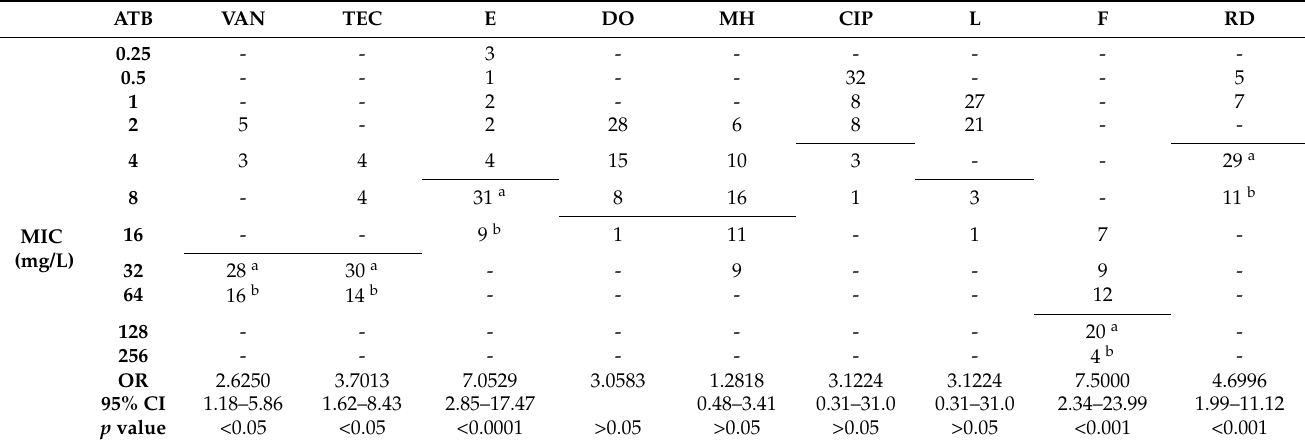
For the antibiotic vancomycin at a concentration of 32.0 mg/L, out of a total of 52 isolates of Enterococcus sp., 28 isolates (53.85%) were resistant, while at a concentration of 64.0 mg/L, 16 isolates (30.77%) were resistant. The antibiotic teicoplanin at a concen- tration of 32.0 mg/L showed a number of resistant isolates (30; 57.67%). At twice the concentration of the antibiotic teicoplanin 64.0 mg/L, 14 isolates were resistant (26.92%), a decrease of 53.33% compared to the dose of 32.0 mg/L. The p value of vancomycin and teicoplanin is significantly lower than the alpha, and this difference is statistically significant ( p < 0.05). Resistance to the antibiotic erythromycin (E) was determined from concentrations of 8.0 mg/L and 16.0 mg/L. At a concentration of 8.0 mg/L, 31 isolates were resistant (59.62%). However, at a concentration of 16.0 mg/L, only 9 isolates (17.31%) were resistant. The odds ratio (OR) is 7.05, which demonstrates that there is a 7.05 times higher chance that an isolate shows resistance at a dose of 8.0 mg/L than at a dose of 16.0 mg/L ( p < 0.0001). For the antibiotic nitrofurantoin (F), the MIC was set at a cut-off value of 128.0 mg/L and 256.0 mg/L. The results showed that 20 isolates (38.46%) were resistant at a concentration of 128.0 mg/L. A statistically significant decrease ( p < 0.001) in the number of resistant isolates of enterococci (7.69%; 4) was found at a concentration of 256.0 mg/L. Rifampicin-resistant strains had an MIC determined from 4.0 to 8.0 mg/L. At a concentration of 4.0 mg/L, 29 isolates were resistant (55.77%), while at a concentration of 8.0 mg/L, 11 isolates (21.15%) were resistant ( p < 0.001). All other antibiotics, doxycy- cline (DO), minocycline (MH), ciprofloxacin (CIP), and levofloxacin (L), did not show a statistically significant change ( p > 0.05) in the number of resistant enterococci at different antibiotic concentrations (Table 1). Table 1. Number of resistant ® , intermediately susceptible (IS), and susceptible (S) species of Enterococcus sp. ATB